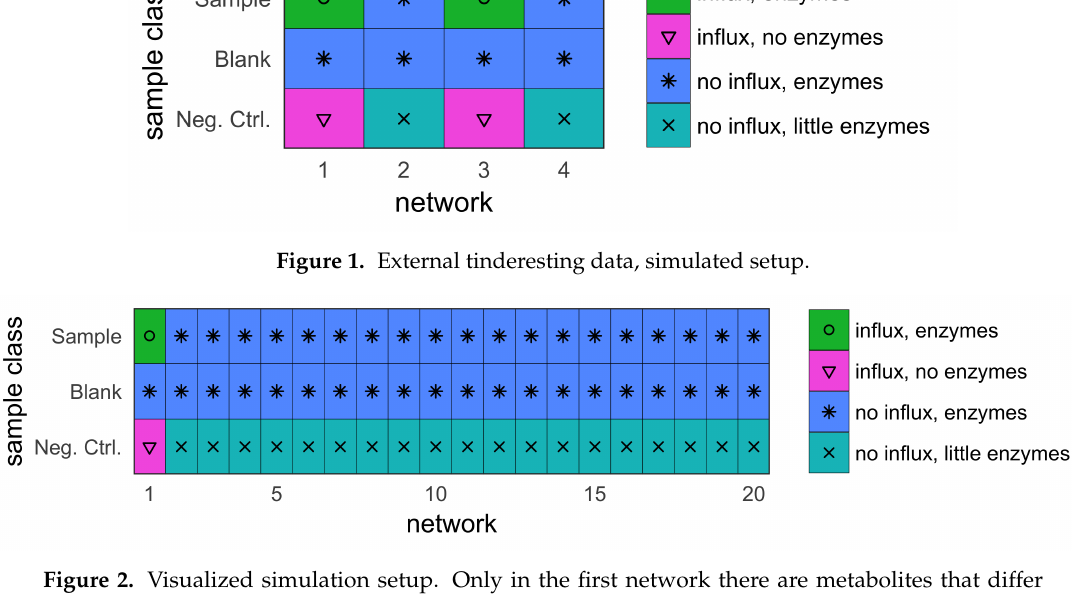
Figure 2. Visualized simulation setup. Only in the first network there are metabolites that differ between sample and blank as well as between sample and negative control. For the remaining 95% of metabolites, there is only a small difference in level of enzymes between sample and negative control. These enzymes convert one metabolite into the other with a rate dependent on the enzyme quantity. Networks 2–19 for the negative control case contain little enzymes instead because there are always some biotransformations occurring. Not including these would produce too large differences between sample and negative control. For the sample vs. blank case, the only difference is in the starting concentrations caused by the Gaussian noise